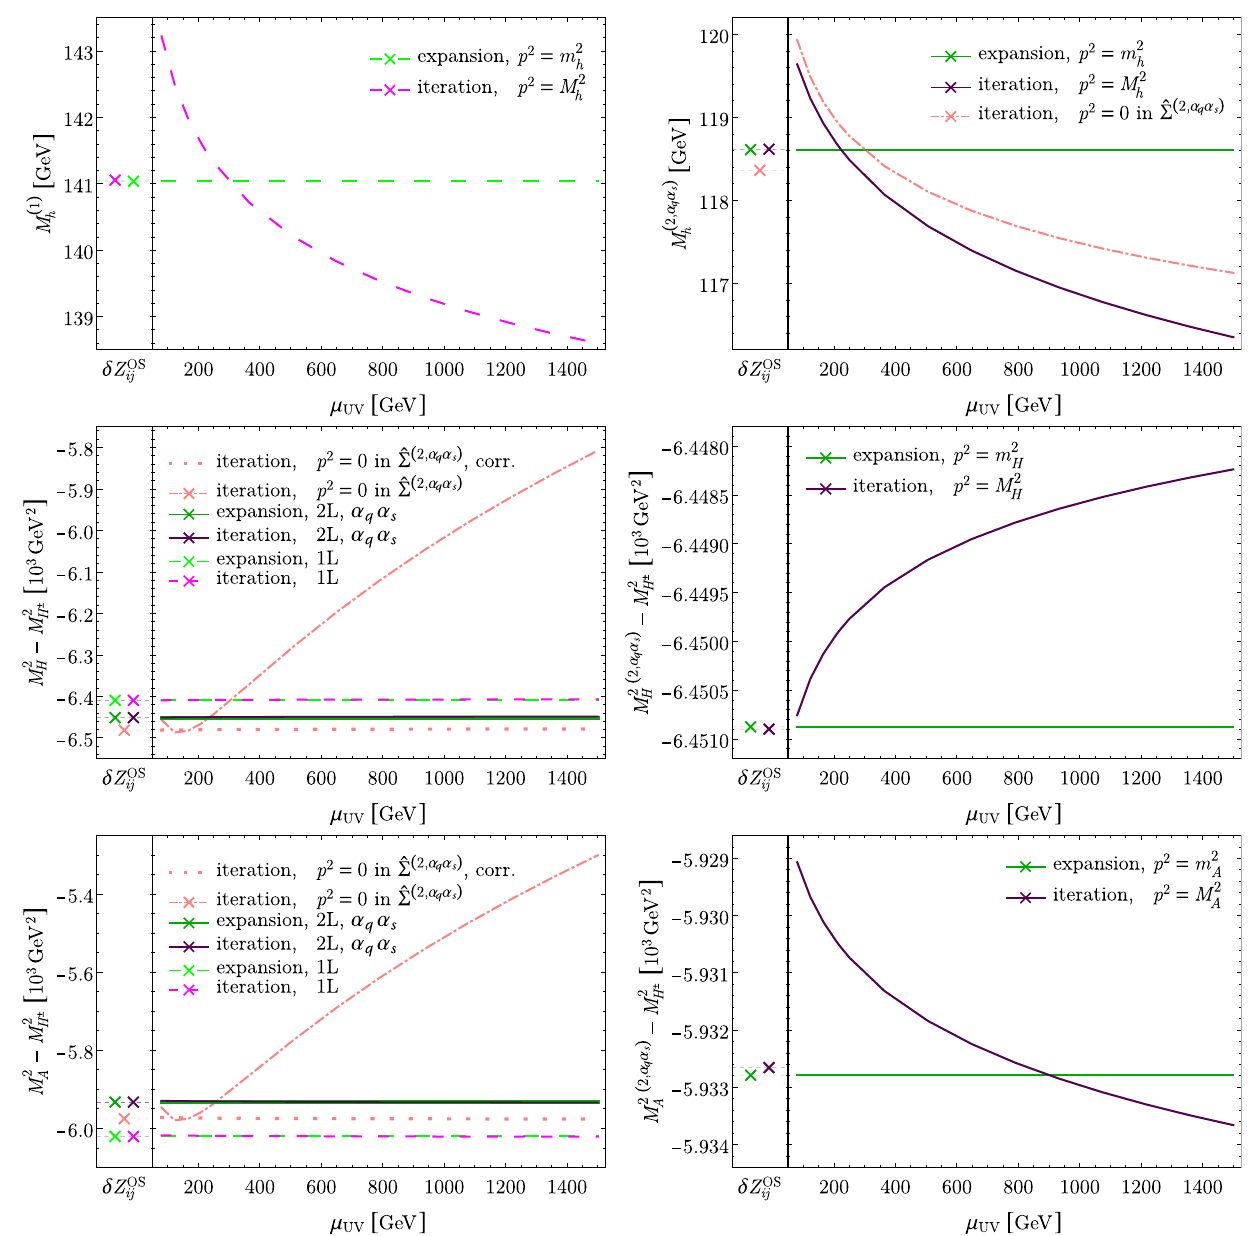
Fig. 3 Dependence on thefieldcounterterms at1L order and O (α q α s ) for M H ± = 1TeV.Theoff-diagonaleffectsareneglectedintheiteration ofthemomentainjectedintheself-energies,sincetheydonotcontribute to the corresponding order. The long-dashed curves correspond to 1L evaluations (green: expansion; magenta: iterative pole search). In the dot-dashed and dotted pink curves, the O (α q α s ) are included in the effective-potential approximation, but an iteration on the momentum of the 1L self-energy is included. In the dot-dashed curves, the countert- erms of the charged-Higgs fields are set to fixed values; in the dotted curves, they are correlated with those of the neutral fields. The solid